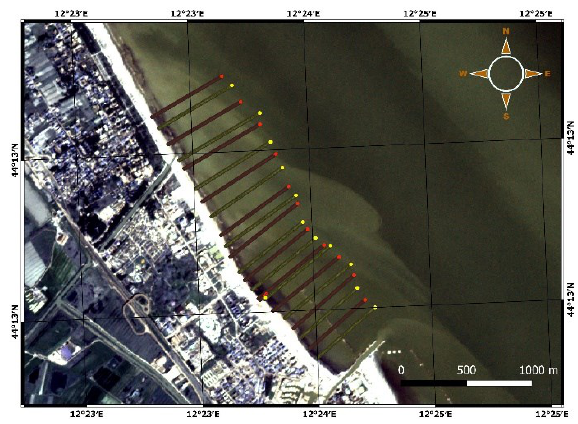
Figure 3. Training (yellow) and validation (red) transects To estimate the performance of the SDB methods, two different algorithms were compared: Support Vector Machine SVM) and Random Forest (RF). The choice of the best configuration of algorithm hyper-parameters was achieved using an iterative procedure that tested against several